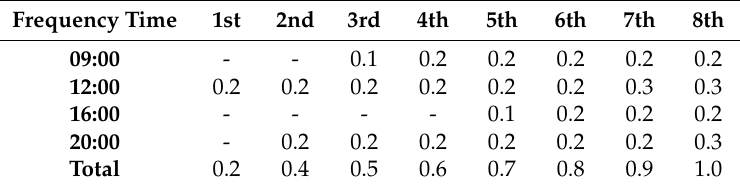
Table 3. Time schedule D-allulose consumption in test drinks for regular ingestion. (unit: g/kg · BW). Frequency Time 1st 2nd 3rd 4th 5th 6th 7th 09:00 - - 0.1 - - - - 20:00 - 0.2